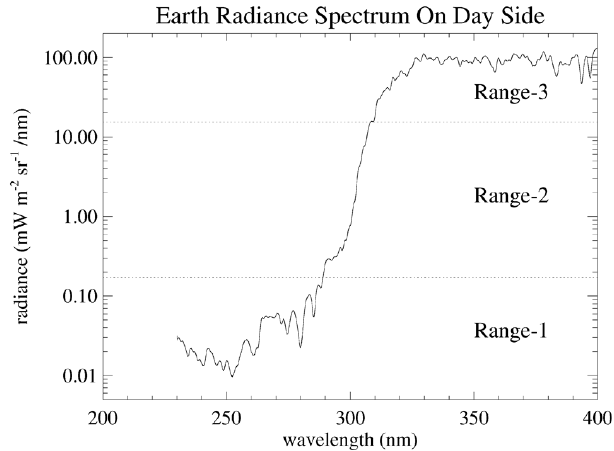
Fig. 5. Backscattered terrestrial radiance spectrum at ultraviolet wavelengths observed by an SBUV instrument. The approximate transition levels between electronic gain ranges are also